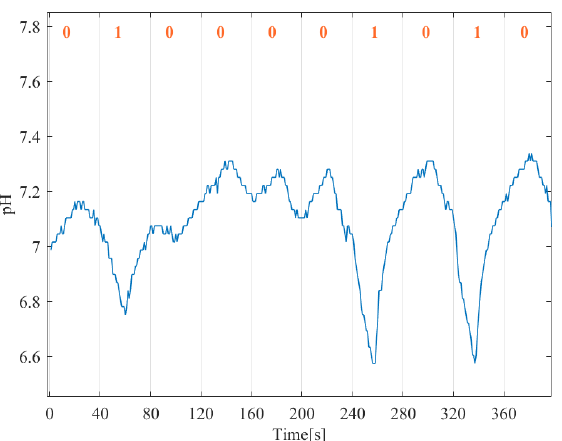
Figure 9. Example of 10 received bits with T s = 40 s after initial delay removal.